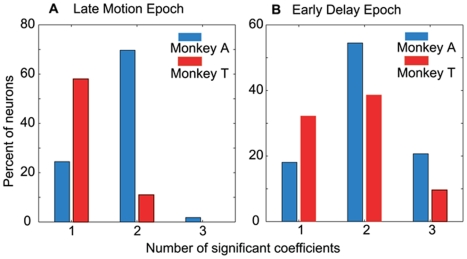
Reward and motion information are multiplexed at the single neuron level.The bars depict the percentage of neurons that are modulated significantly by one, two or three model parameters: T1val, T2val or coherence. A. Data from the second half of the motion epoch. B. Data from the early delay epoch. Red bars: monkey A. Blue bars: monkey B.